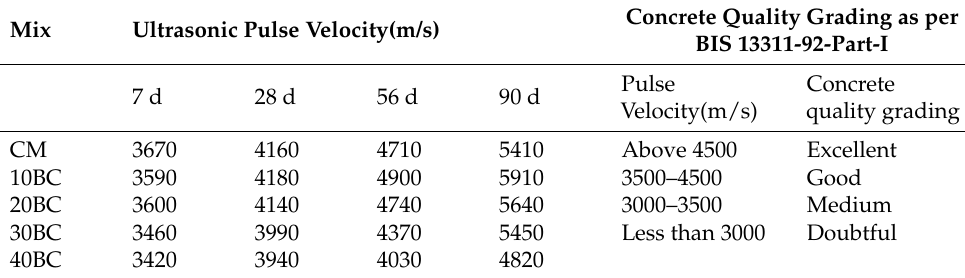
Table 5. Ultrasonic pulse velocity and concrete quality grading as per BIS 13311-92-Part-I.